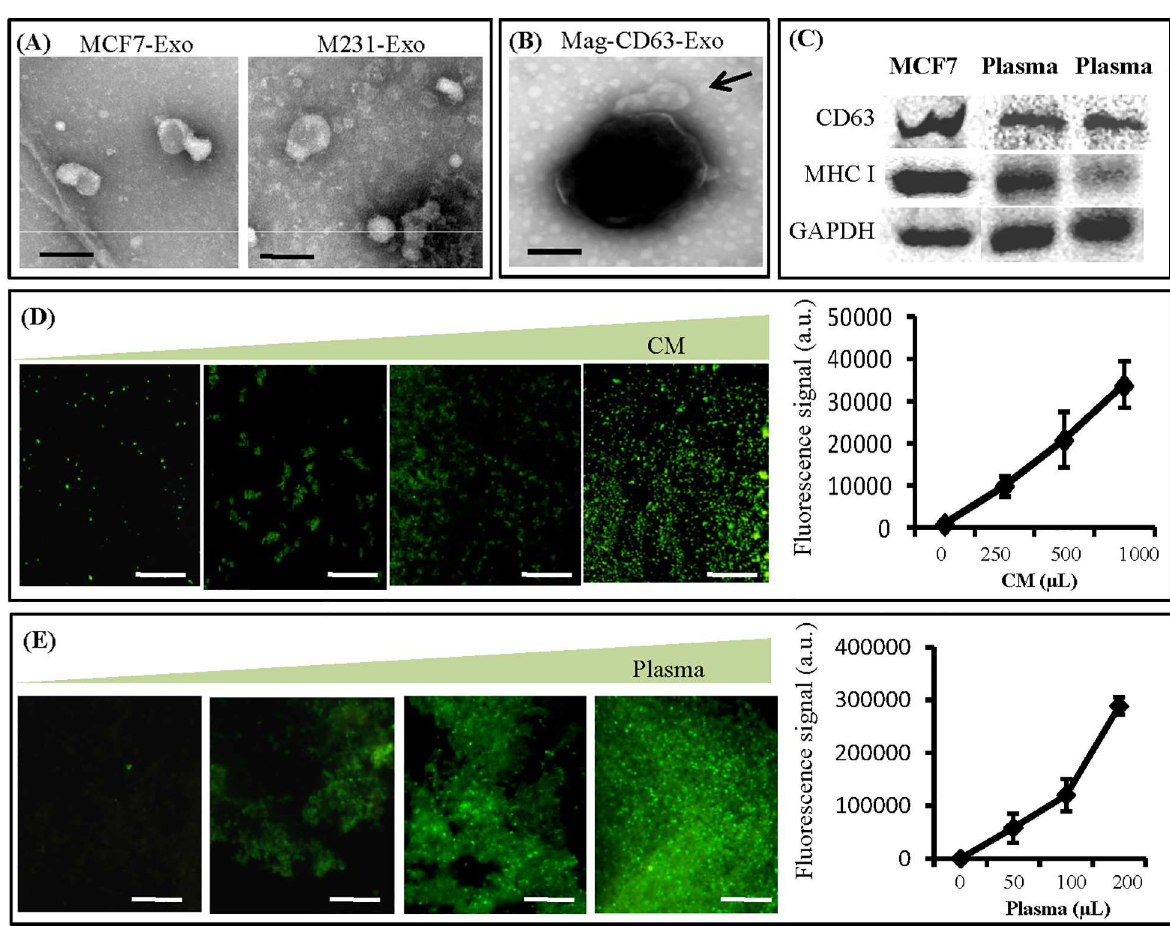
Fig 2. Verification of immunocapture of exosomes on the chip. (A) MCF7 and M231 secreted exosomeswere negatively stained using uranylacetate and viewedby TEM. These exosomes showedtypical cup-shaped morphologywith diameters less than 100 nm. (B) TEM images of the immunomagneticparticles with. The arrow indicatedtwo exosomescaptured by a magneticnanoparticle.(C) Western blot analysisof CD63, MHC I, and GAPDH expressionin exosomes isolatedfrom MCF7 culture medium and two plasma samples. (D) Quantificationof total exosomes capturedby Mag-CD63 from different volumes of M231 culture medium. A stable on-chip capture efficiency was demonstrated (R 2 = 0.93). (E) Quantification of total exosomes captured by Mag-CD63from different volumesof humanplasma sample. A stable on-chip capture efficiency was demonstrated (R 2 = 0.995). The scale bars represent 100 nm in (A-B) and 50 μ m in (D-E).